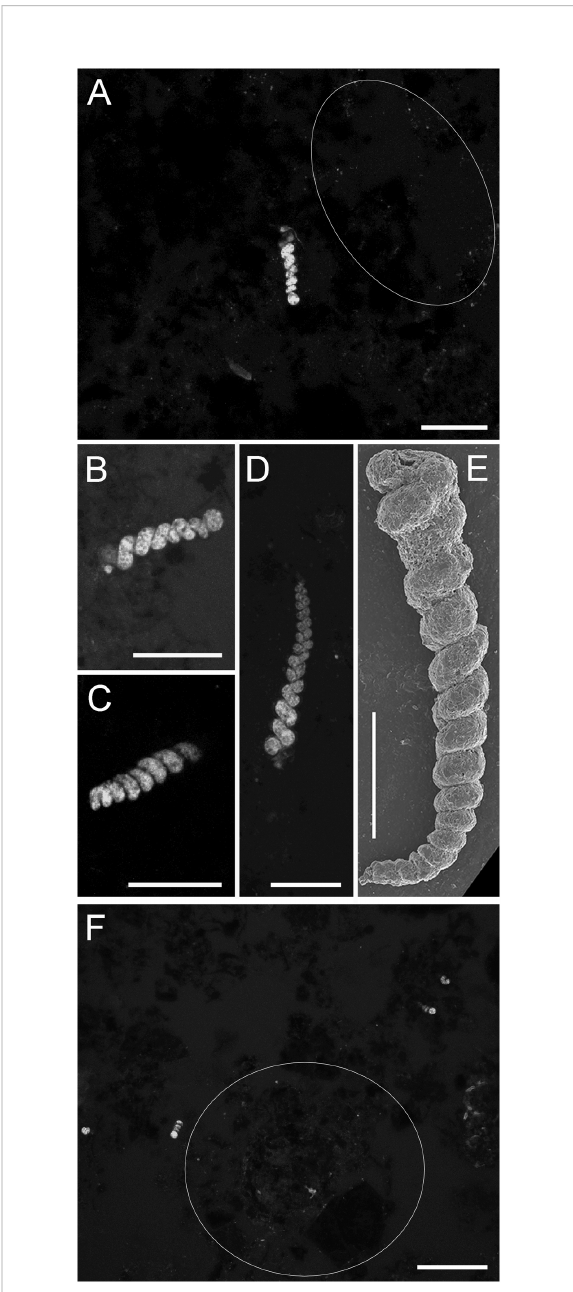
FIGURE 10 Foraminifer Turritellella sp., from chimney-base sediments. (A – D, F) LSCM images (z-stacks) of specimens from FLEC sections. (A) Specimen with aperture up (Core 9; 3 mm depth). (B, C) Specimens oriented nearly horizontally (Core 9, 11, respectively, both ~0.5 mm depth). (D) Specimen with aperture down (Core 9, 0.5 mm depth). (E) SEM micrograph showing spiral growth habit and fi ne-grained test (0-1-cm interval, SEM core, Myojin-Knoll chimney-base sediments). (F) Overview showing four specimens (Core 8, ~1 mm depth). White outlines in (A, F) highlight areas of microbe aggregation. Number of images compiled/distance between images (µm): (A) =21/0.3; (B) =5/0.3; (C) = 44/0.3; (D) = 8/ 0.3; (F) = 37/0.7. Scales: (A – E) = 50 µm; (F) = 200